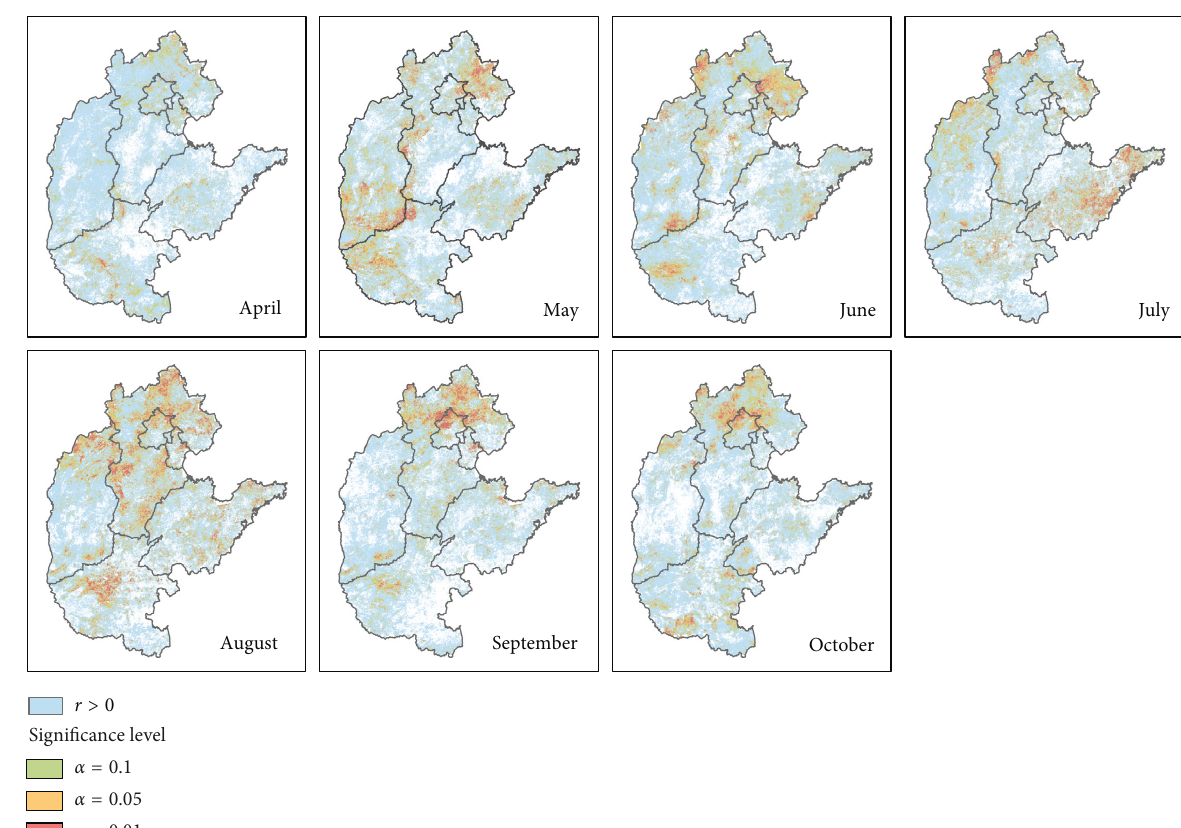
Figure 11: Spatial distribution of the significance level between SMAI-1 and VCI in North China.